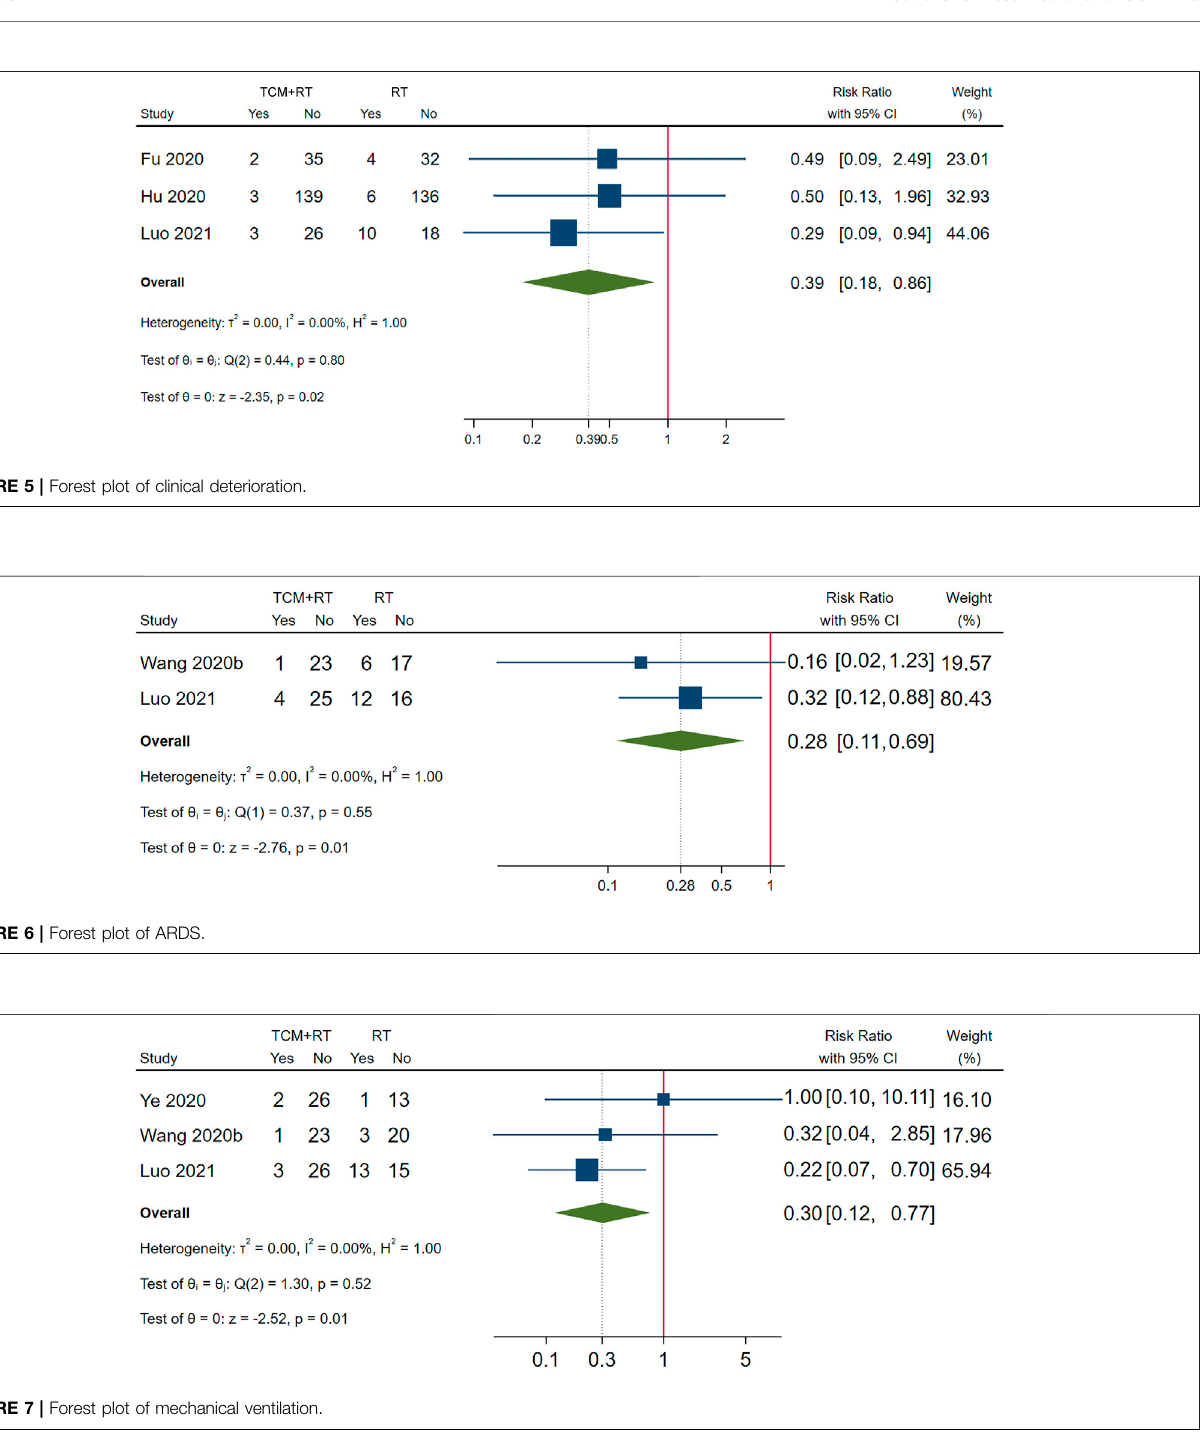
the SARS-CoV-2 nucleic acid test was also observed ( Figure 4 ;